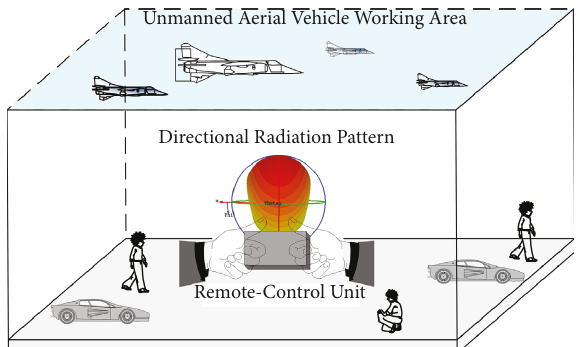
Figure 1: Directional radiation pattern of the remote-control unit for UAV